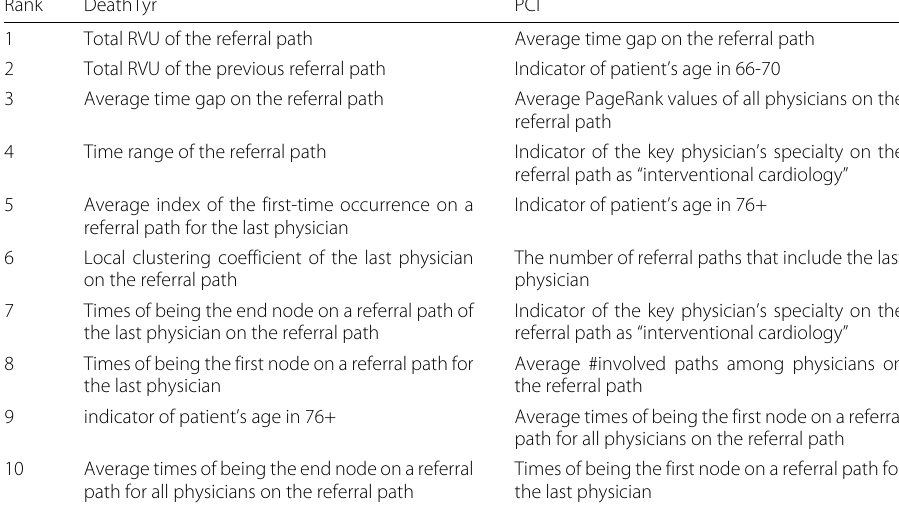
selection method (Genuer et al.